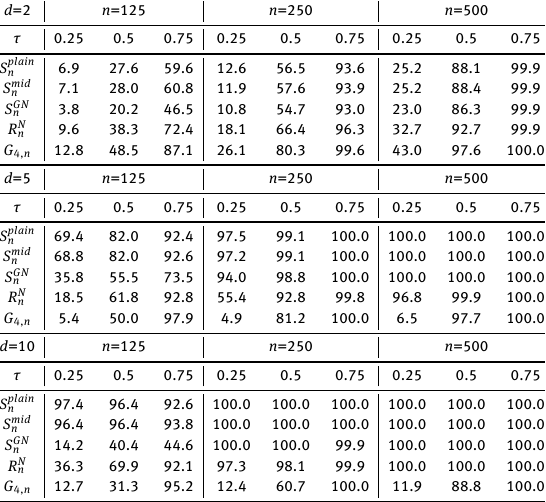
Table 5: Percentages of rejection at 5% significance level, as estimated from 1000 replicates, for the tests based on S plain n , S mid n , S GN n , R N n and G 4, n under the Squared Laplace copula (*Kendall’ τ refers to the associated Laplace copula).